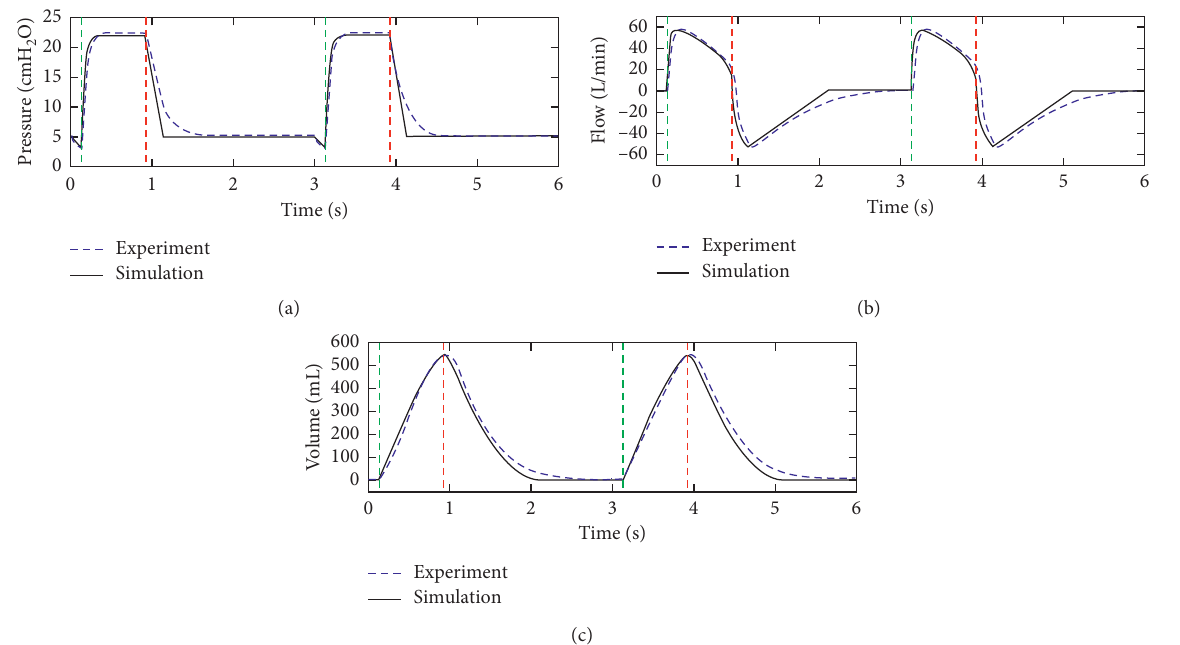
Figure 4: The ventilator waveforms during pressure support ventilation. The waveforms include the pressure curve, the flow curve, and the volume curve.